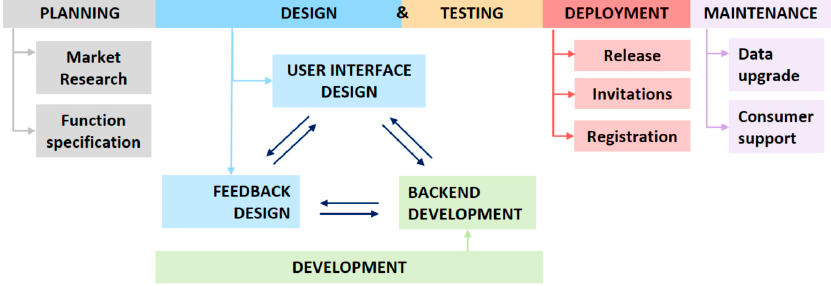
Figure 4. Portal design and user onboarding process.